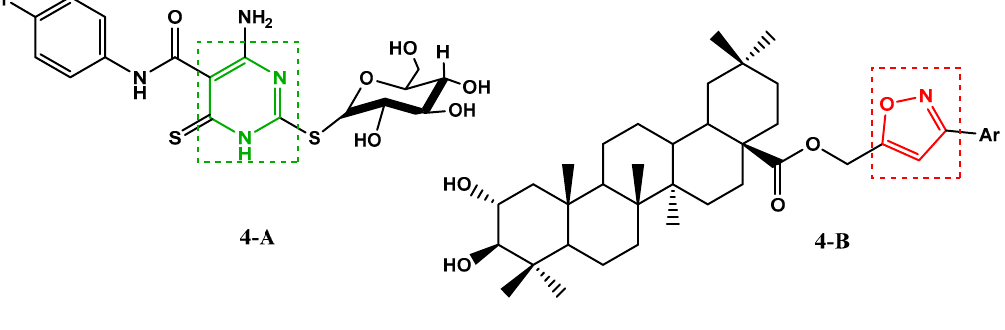
Figure 4. Previously reported anti-SARS-CoV-2 molecules.